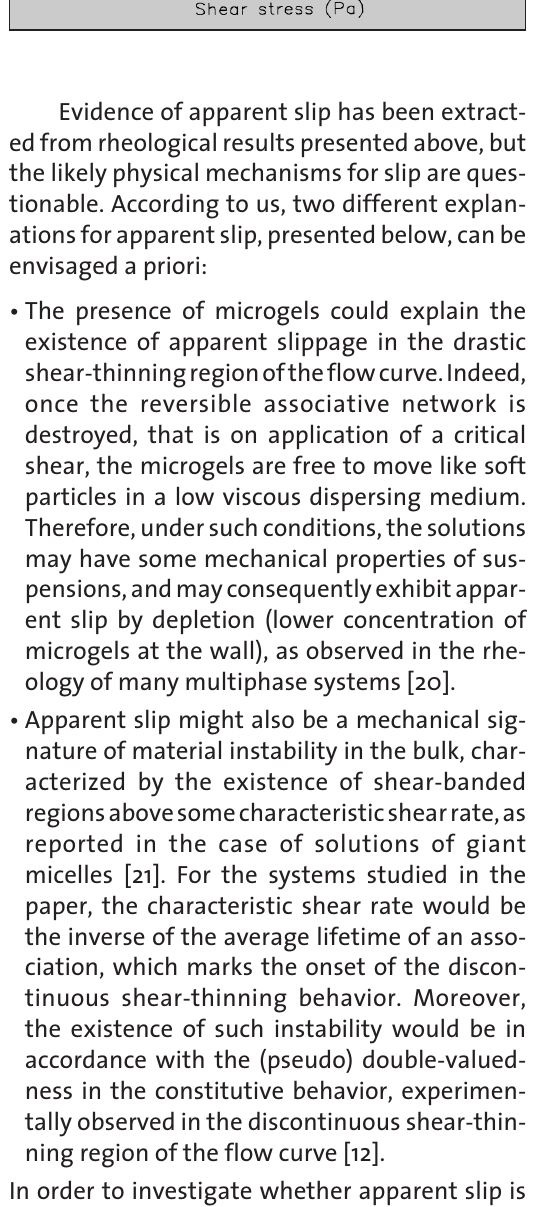
Figure 5 (right): The slip velocity as a function of the imposed shear stress for a 1% w/w hydrophobically modified (hydroxypropyl) guar aqueous